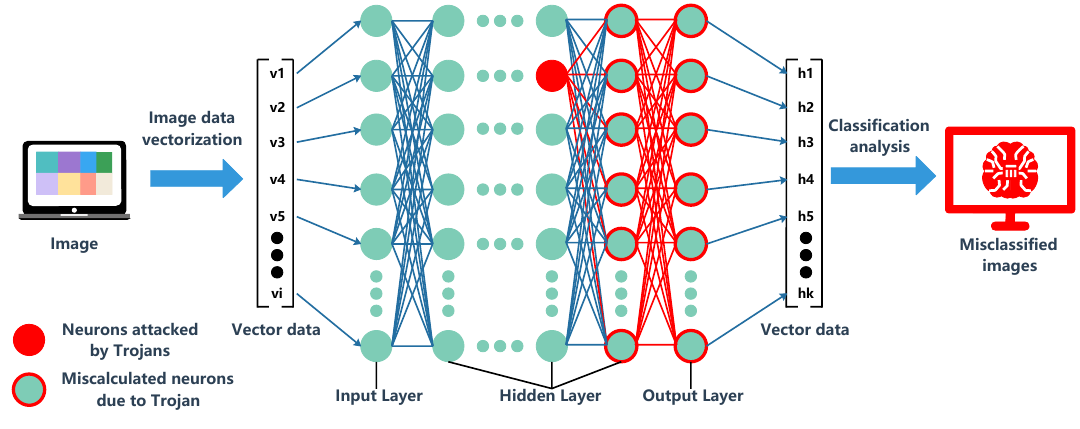
Figure 6. Threat model of neurons attacked by